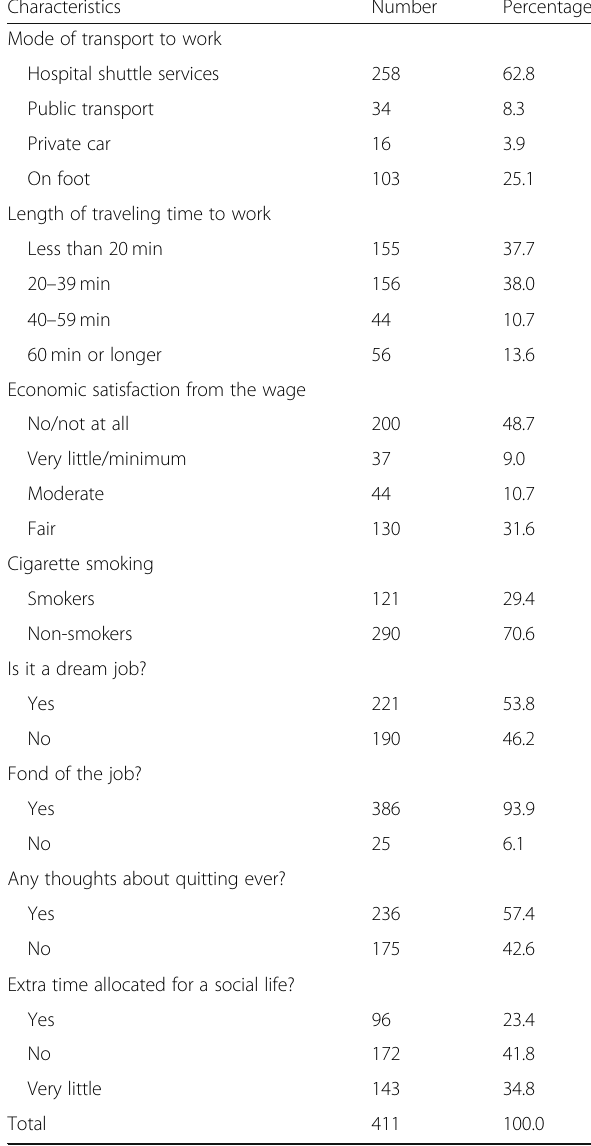
Table 3 Distribution of nurses by the selected psychosocial characteristics ( N = 411)